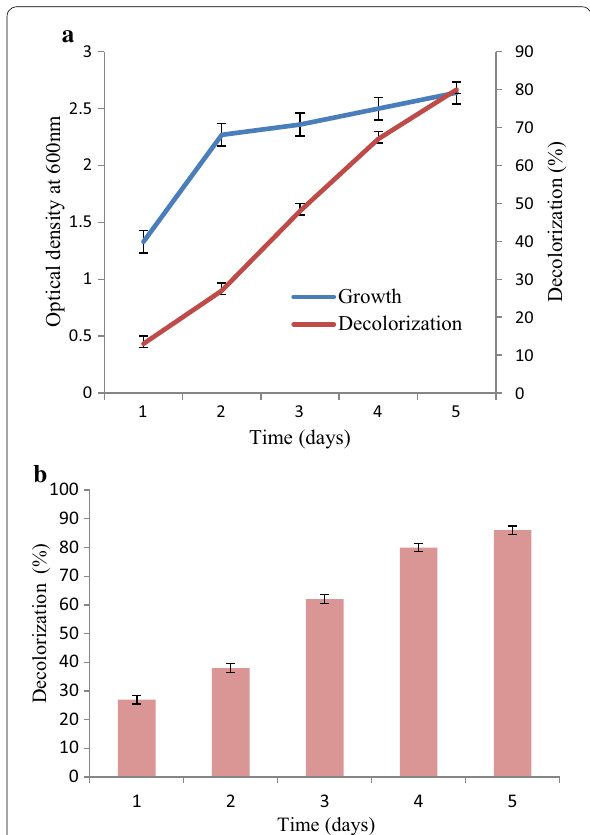
Fig. 3 a Effect of growth (O.D) on decolorization (%) of A. aquatilis 3c incubated for 5 days. b A. aquatilis 3c potential to decolorize multiple dyes incubated at 37 °C for a period of 5